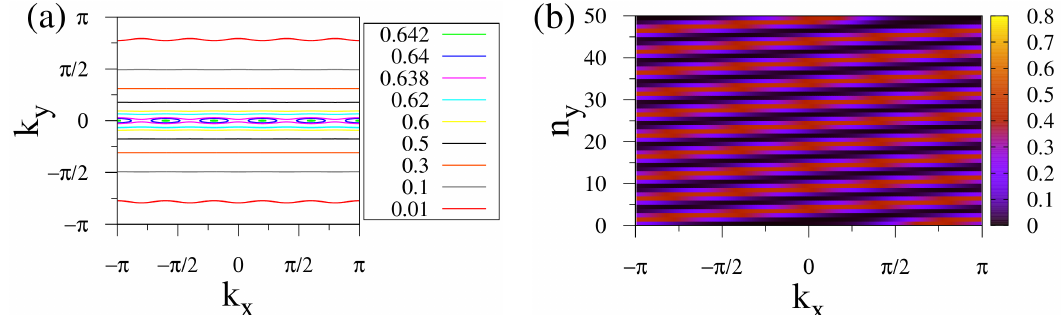
Figure 7: (a) A contour plot of the “quasi-momentum” (Fourier transform defined, here only, with respect to a 1 × 1, rather than 1 × q = 1 × 5, unit cell) distribution of the dissipative Hofstadter model on the first Brillouin zone, which can be extracted from a time-of-flight measurement [ 33, 34 ] . The q = 5 fold periodicity in the k x direction reflects the periodicity of the Hofstadter reference Hamiltonian (13). The parameter values are as in Fig. 3. (b) A color map of the mixed quasi momentum-real space distribution (along the x and y directions, respectively), which can be inferred from a hybrid time-of-flight measurement [ 86 ] . The spatial density profile in the y direction winds by one unit cell (of size q = 5) as k winds through the Brillouin x = 1 [ cf. Eq. (19) ] . The system is a 50-site-wide strip whose zone, showing that C 1 long axis is x ; similar results hold in the presence of a trap [ 86 ] . k and k are x y here dimensionless, or, equivalently, measured in units of 1 / d , the inverse 2D lattice